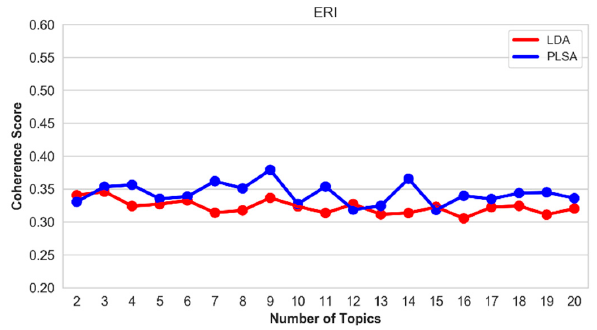
Figure 14. Coherence score of the top-20 topics on the RCD hallmark.